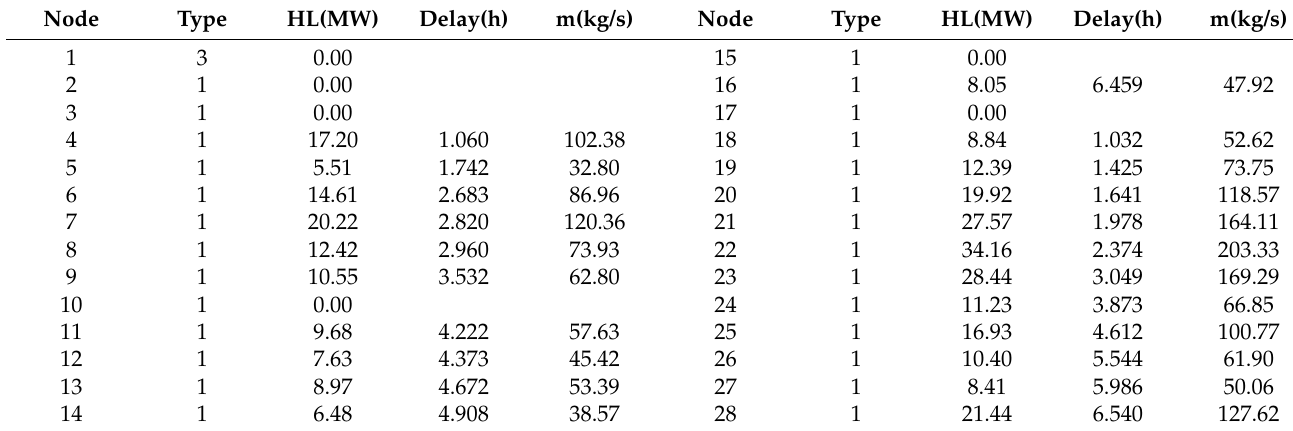
Table A1. Heat network node parameters.